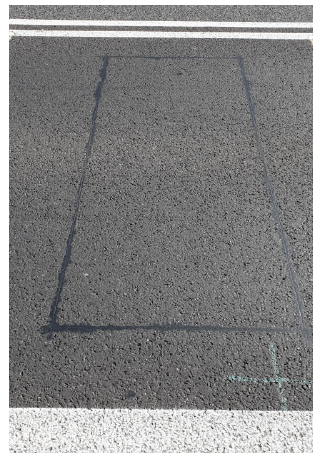
Figure 8. Loop sensors.